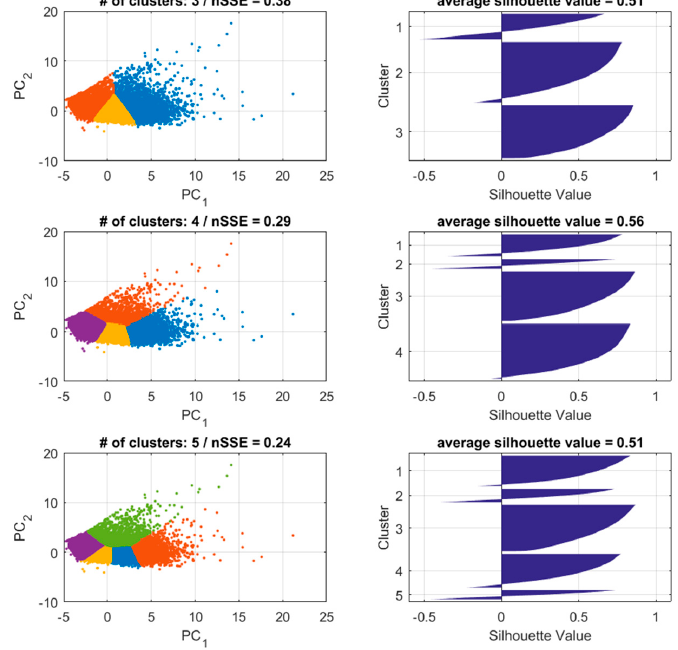
Figure 11. Scatter-plots for the first two principal components (PC 1 and PC 2 ) and silhouette plots for 3, 4 or 5